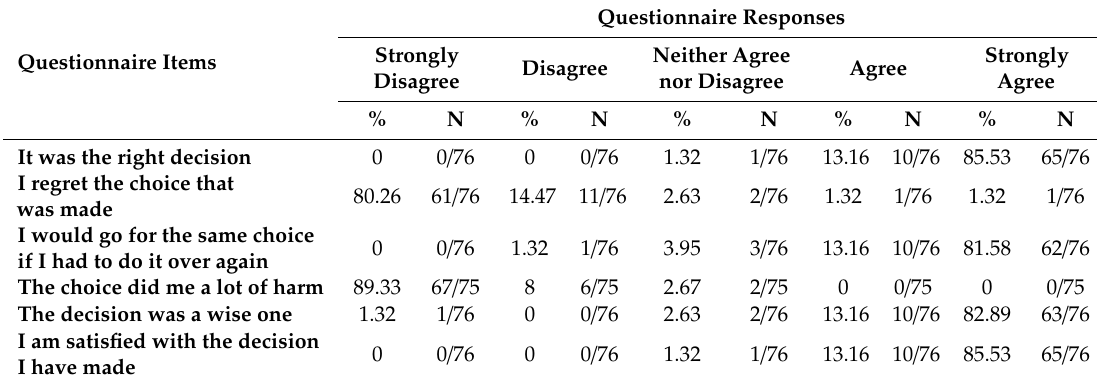
Table 6. Decision Regret Satisfaction questionnaire responses according to individual questionnaire